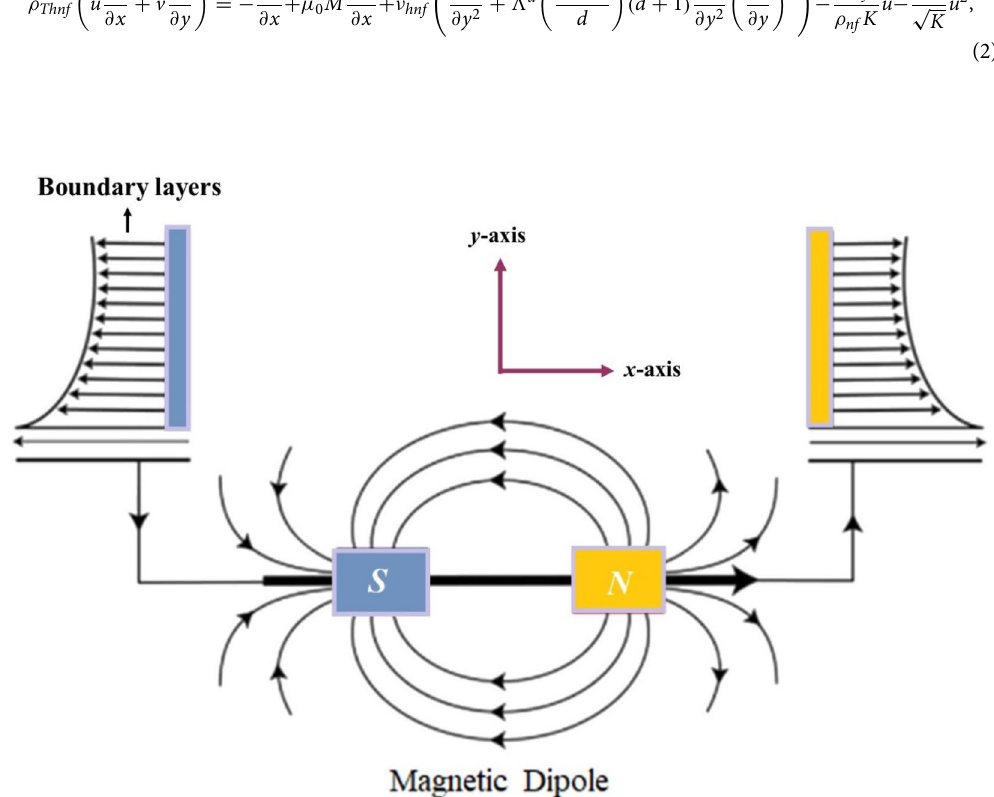
Figure 1. Fluid flow geometrical